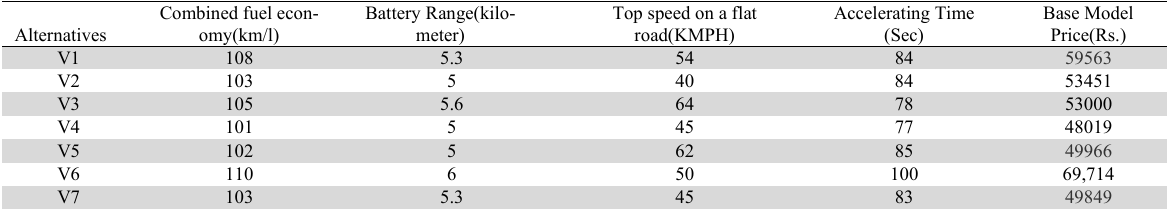
The information of the case study